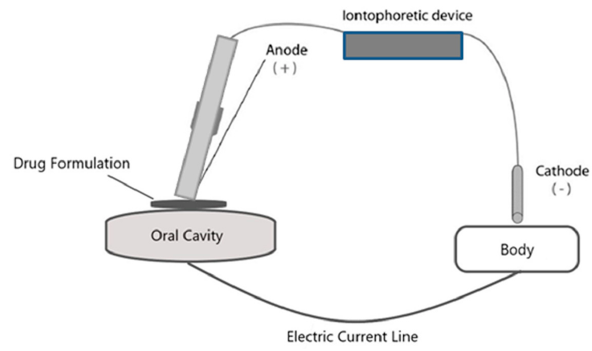
Figure 3. Schematic drawing of an iontophoretic device for oral cavity. Modified from reference [58].